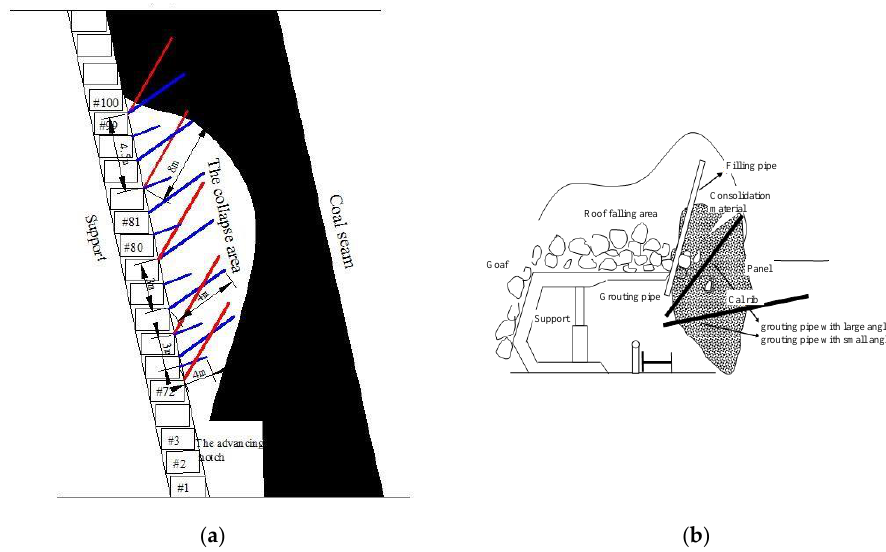
Figure 18. Distribution of the grouting holes. ( a ) Plane layout of the grouting holes and ( b ) layout of the grouting holes.